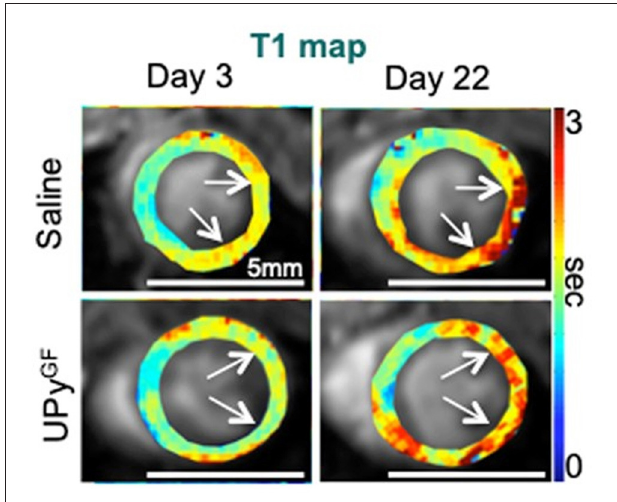
FIGURE 9 | Extracellular matrix and fibrosis imaging. Longitudinal T 1 mapping uncovers reduced fibrosis throughout cardiac healing in UPyGF-hydrogel-injected infarcts. Longitudinal T 1 mapping of healthy hearts and hearts after I/R injected with saline or UPyGF-hydrogel [adopted from